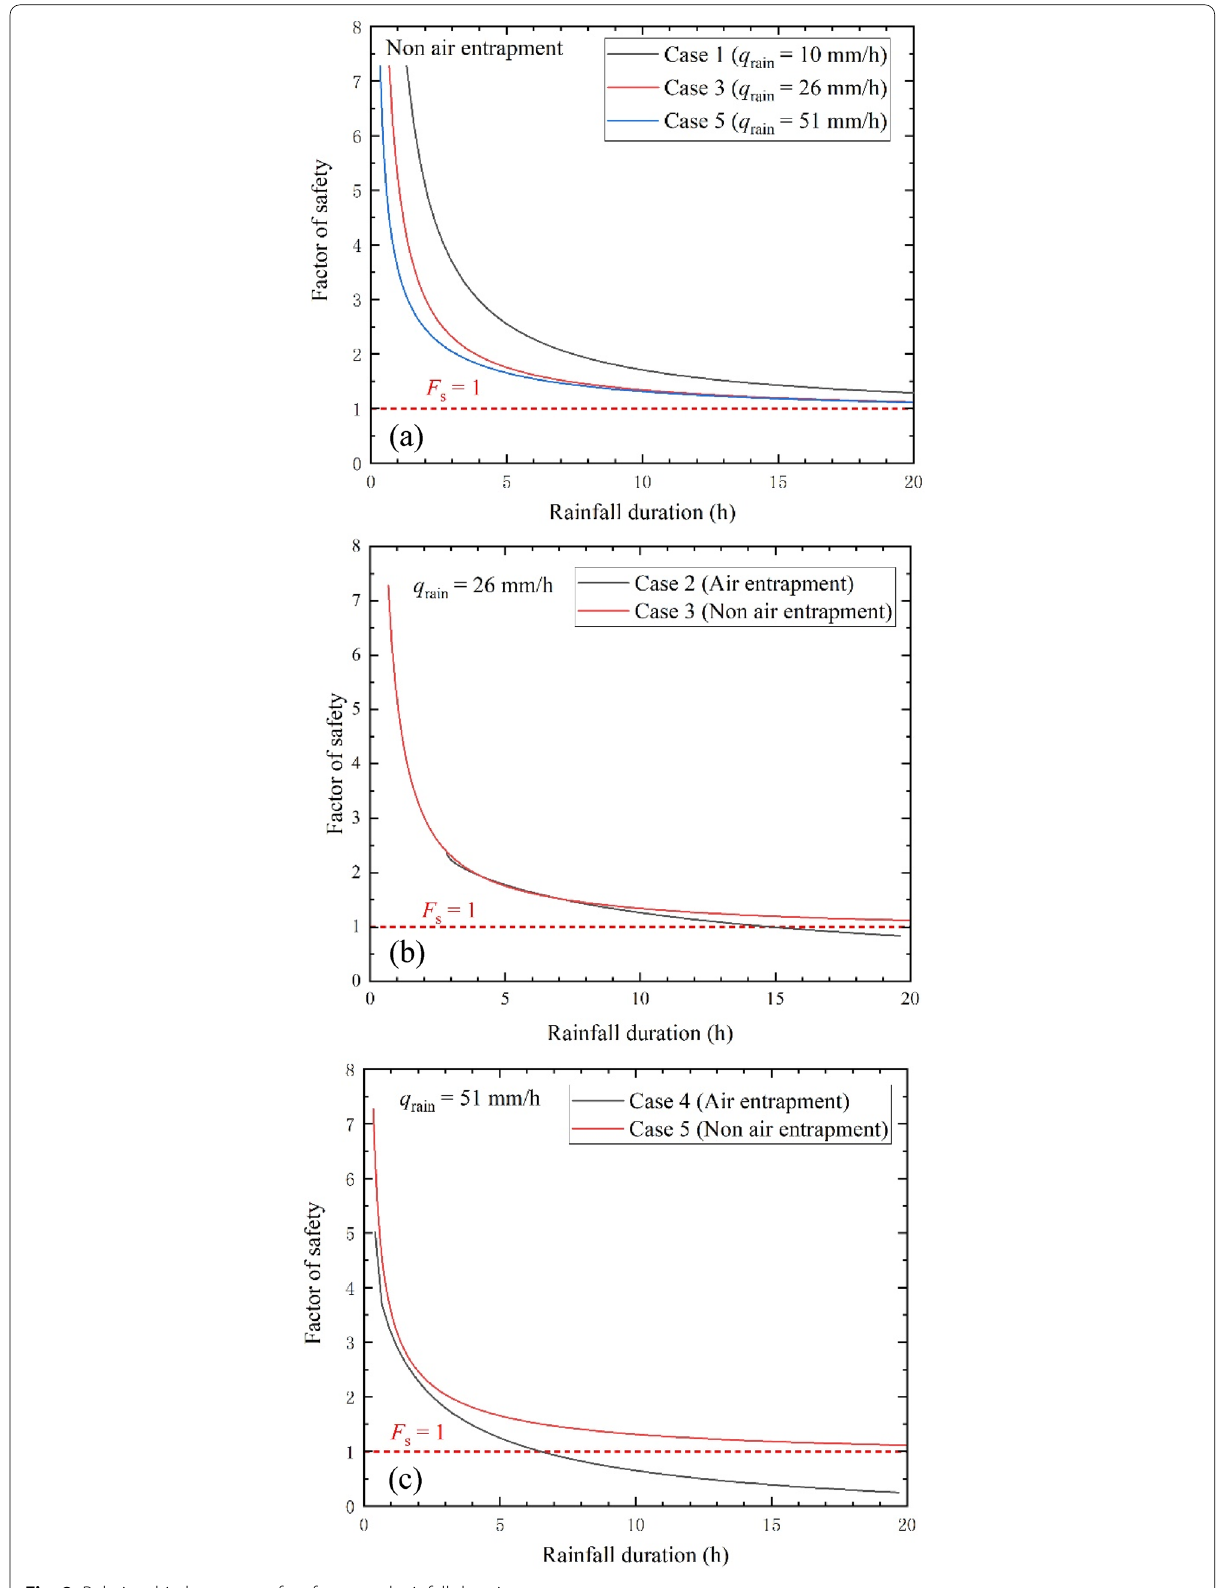
Fig. 8 Relationship between safety factor and rainfall